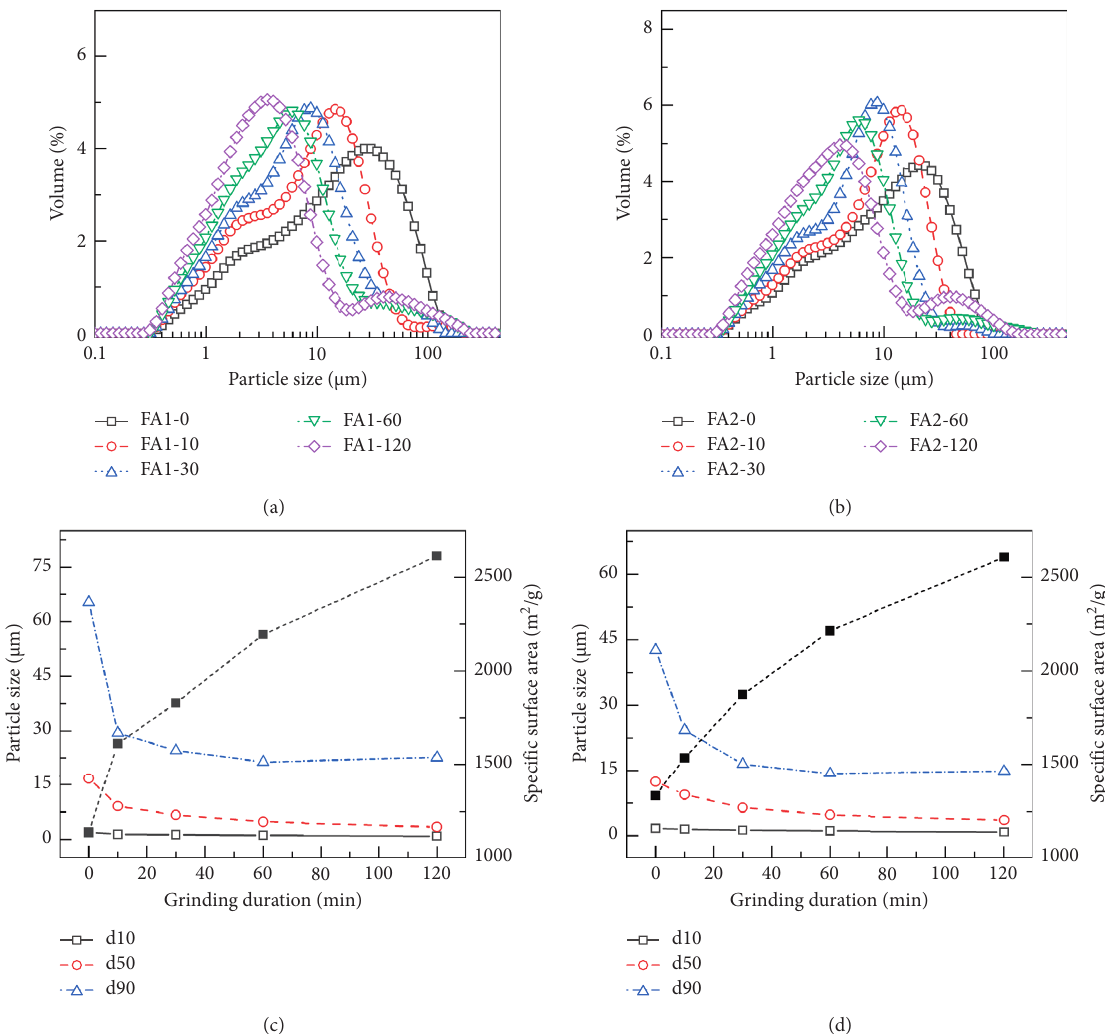
Figure 3: Particle size distribution of (a) FA1 and (b) FA2; characteristic particle parameters (c) FA1 and (d)